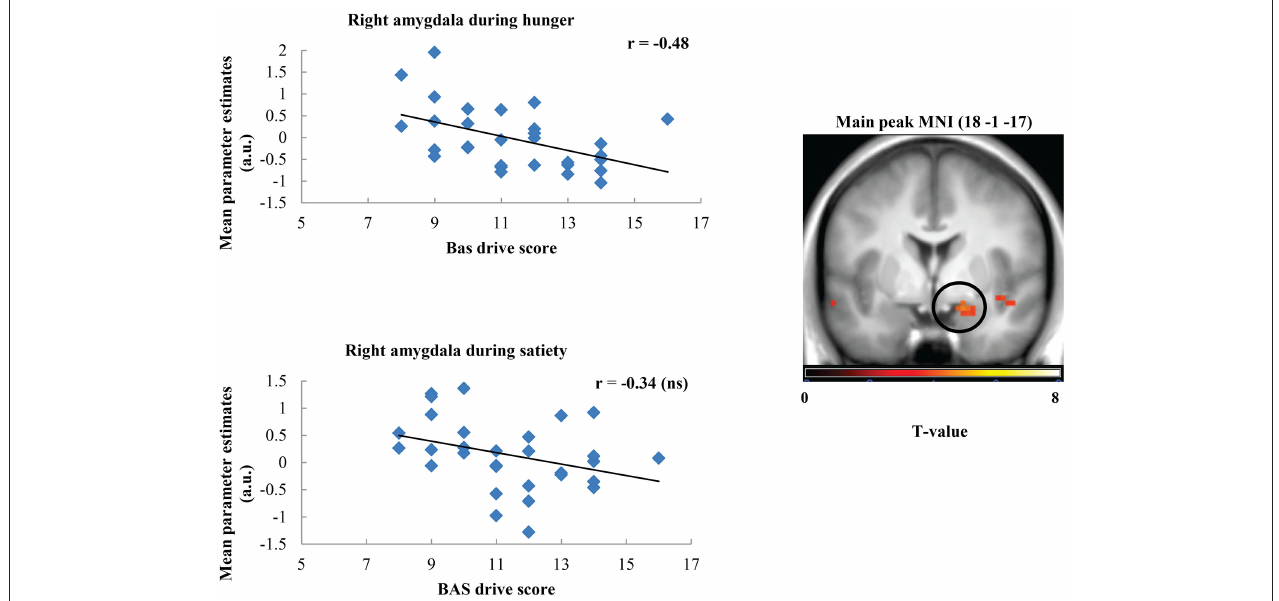
FIGURE 4 | Scatterplot of brain activation in response to oral calories (maltodextrin and sucralose minus sucralose) and reward sensitivity (BAS drive score) during hunger (significant) and satiety (not significant) in the right amygdala.